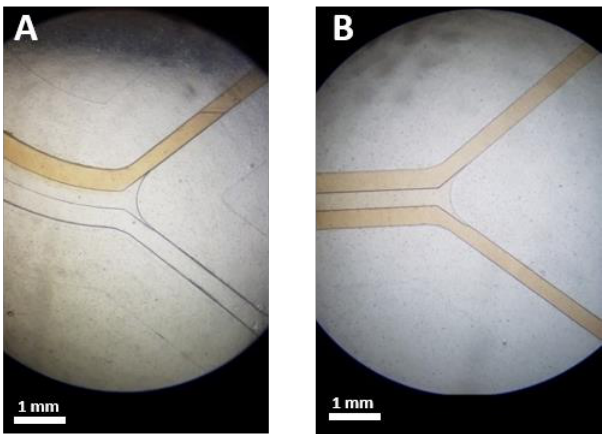
Figure 9. Images of the left side spiral at ( A ) Inlets, ( B ) outlets showing the effect of the secondary flow on mixing the colored fluid throughout the entire microchannel. The colored fluid and DI water were pumped through the microchannel from the inner and outer inlets, respectively. Table 1. The microchip’s specifications in terms of sample flow rate, microchannel Reynolds number, and Dean number.